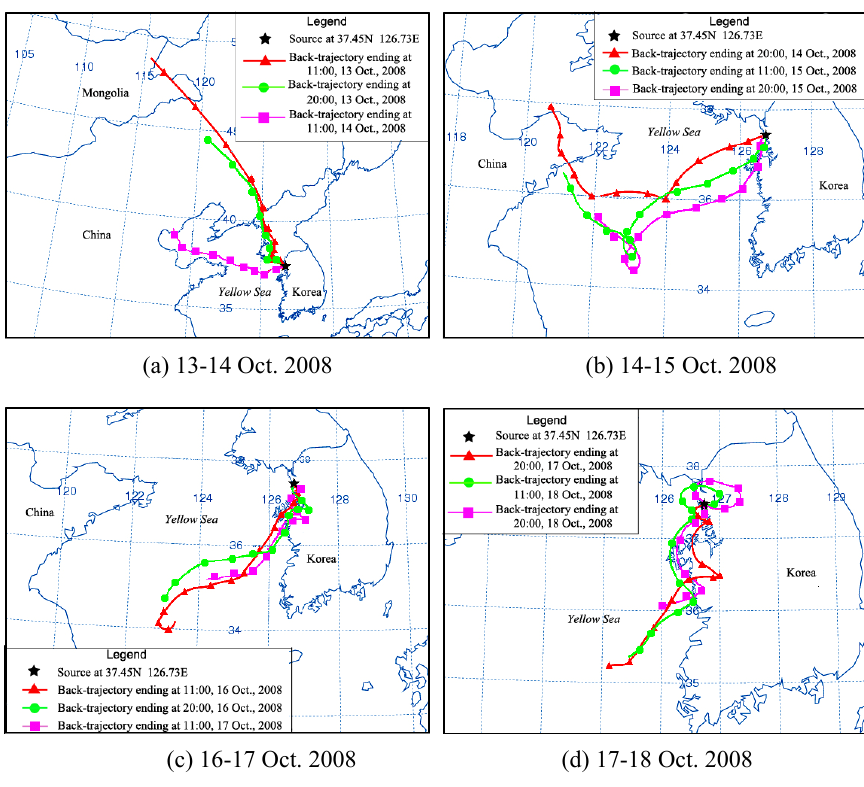
Fig. 2. 72-h backward air-mass trajectories at sampling height (around 40ma.s.l.) from 13 to 18 October 2008 (KST).